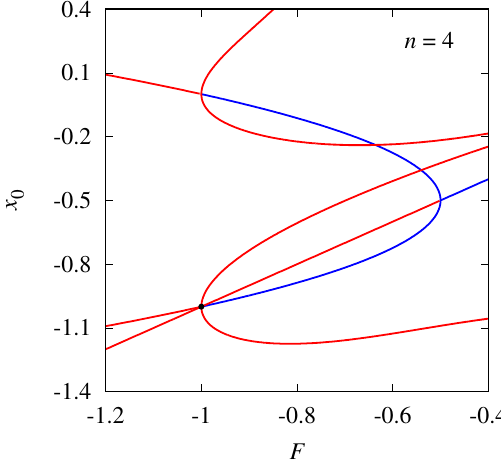
Figure 3. Bifurcation diagram for system L − 1,1,0 ( n ) with n = 4. The equilibrium x F = ( F , F , F , F ) becomes unstable through a supercritical pitchfork bifurcation at F = − 1/2 and the two newly created branches bifurcate through a subcritical pitchfork bifurcation at F = − 1. The bullet marks a Hopf bifurcation of x F at F = − 1.